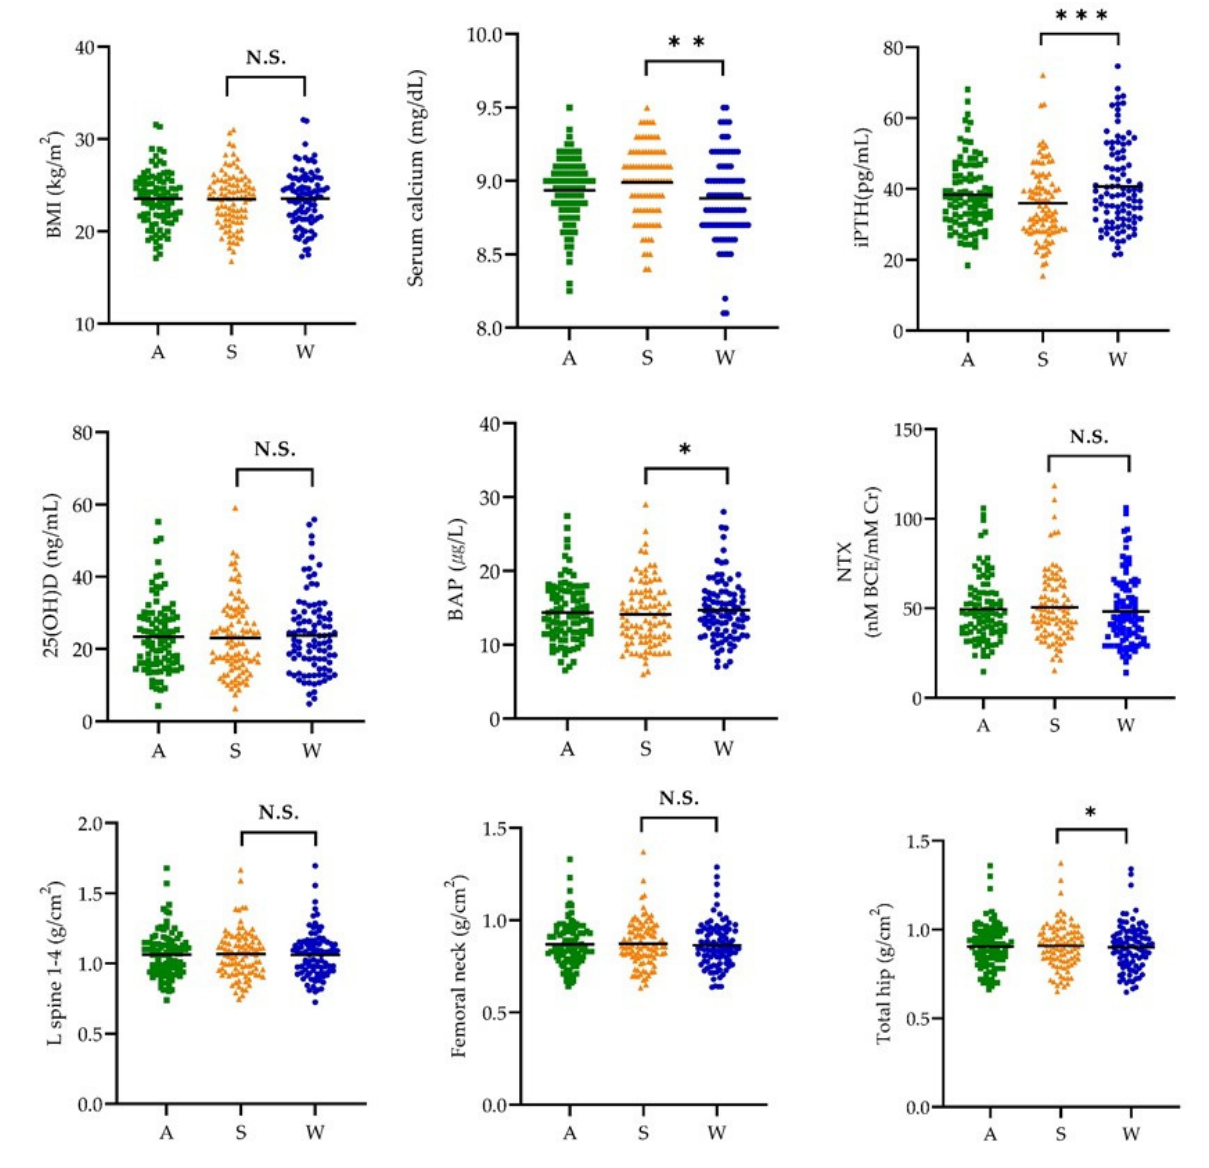
Figure 1. Body mass index, biochemical indices, and bone mineral density by season ( n = 96). Solid line: mean value; A, annual average; S, summertime; W, wintertime; BMI, body mass index; iPTH, intact parathyroid hormone; BAP, bone alkaline phosphatase; NTX, type I collagen cross-linked N-telopeptide; BMD, bone mineral density. The p -values for BMI, iPTH, BAP, NTX, and BMD were derived from the paired t -test. The p -values for the serum calcium and serum 25(OH)D levels were derived from the Wilcoxon signed-rank test. *** p < 0.001, ** p < 0.01, * p < 0.05. N.S.: not significant.